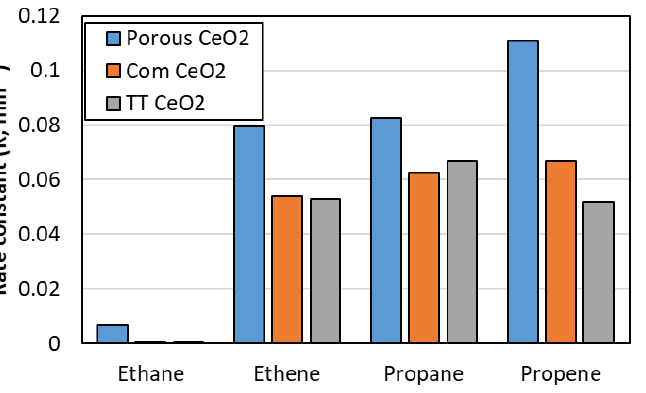
Figure 8. The first-order rate constant of the hydrocarbon elimination over porous, commercial, and thermally treated ceria.